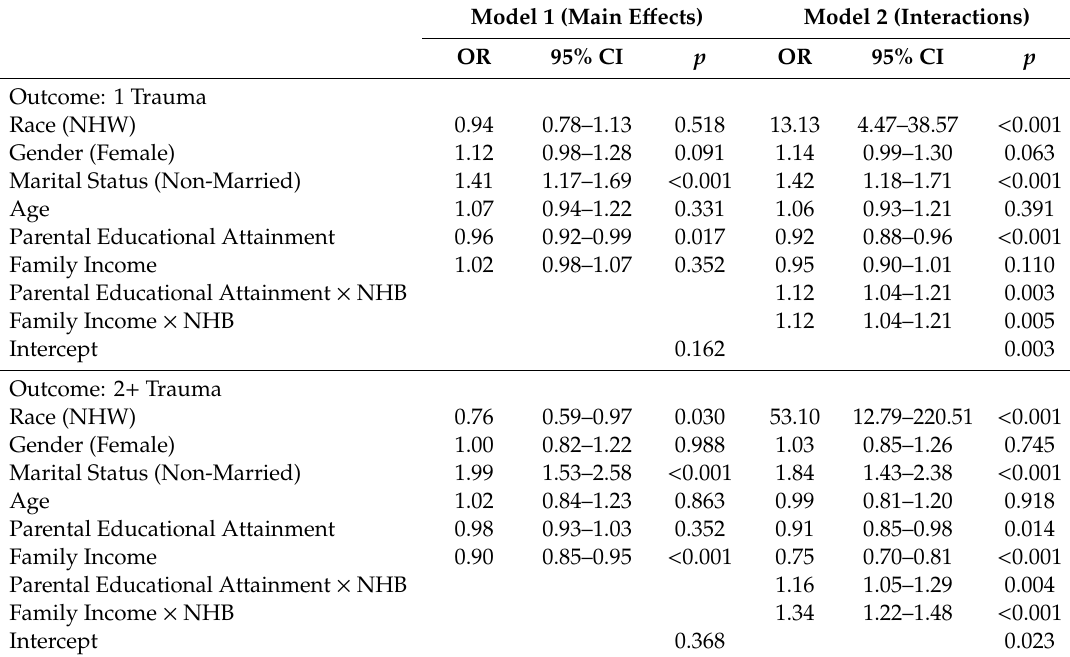
Table 2. Summary of polynomial regressions overall ( n = 4696) .